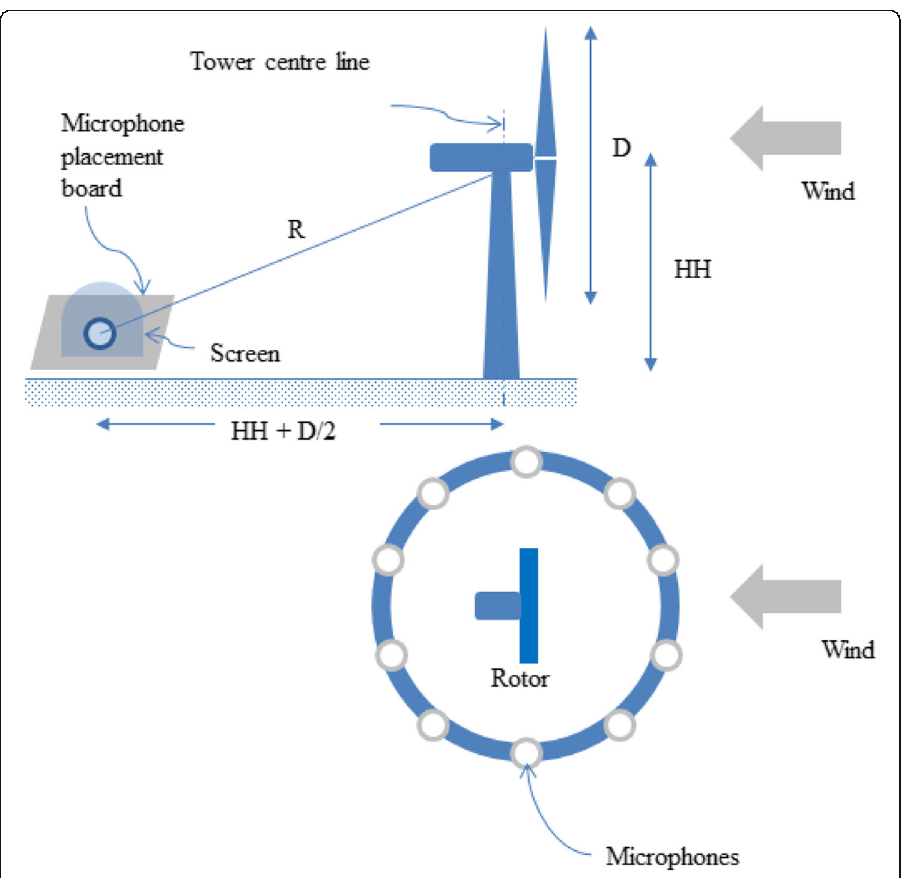
Fig. 3 Illustration of microphone position surrounding the source located in centre as well as the microphone measurement distances and position according to IEC 61400 – 11 standards with respect to source